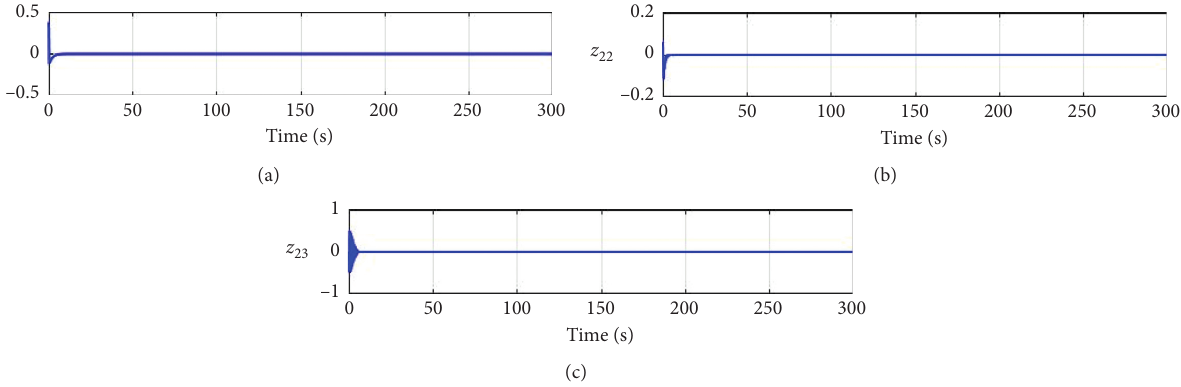
Figure 6: Trajectories of errors z